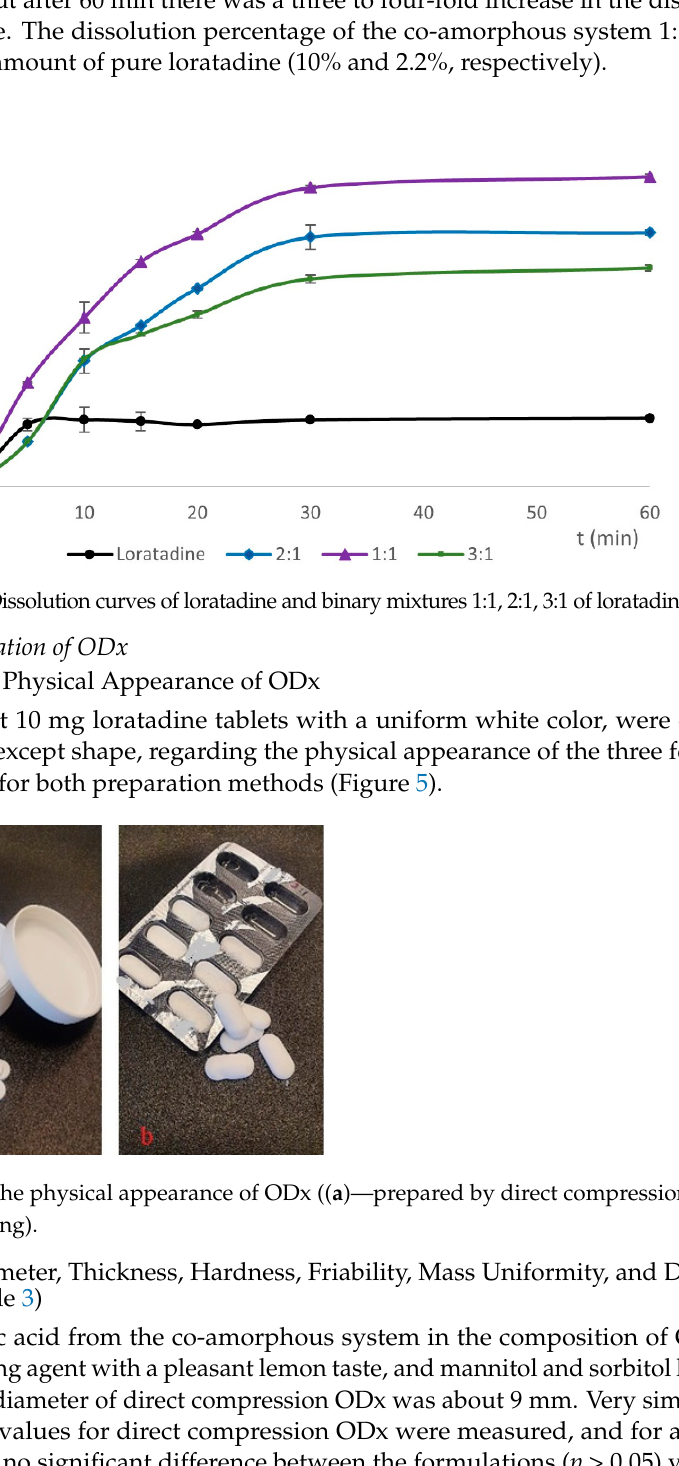
Table 3. Parameters of the ODx.